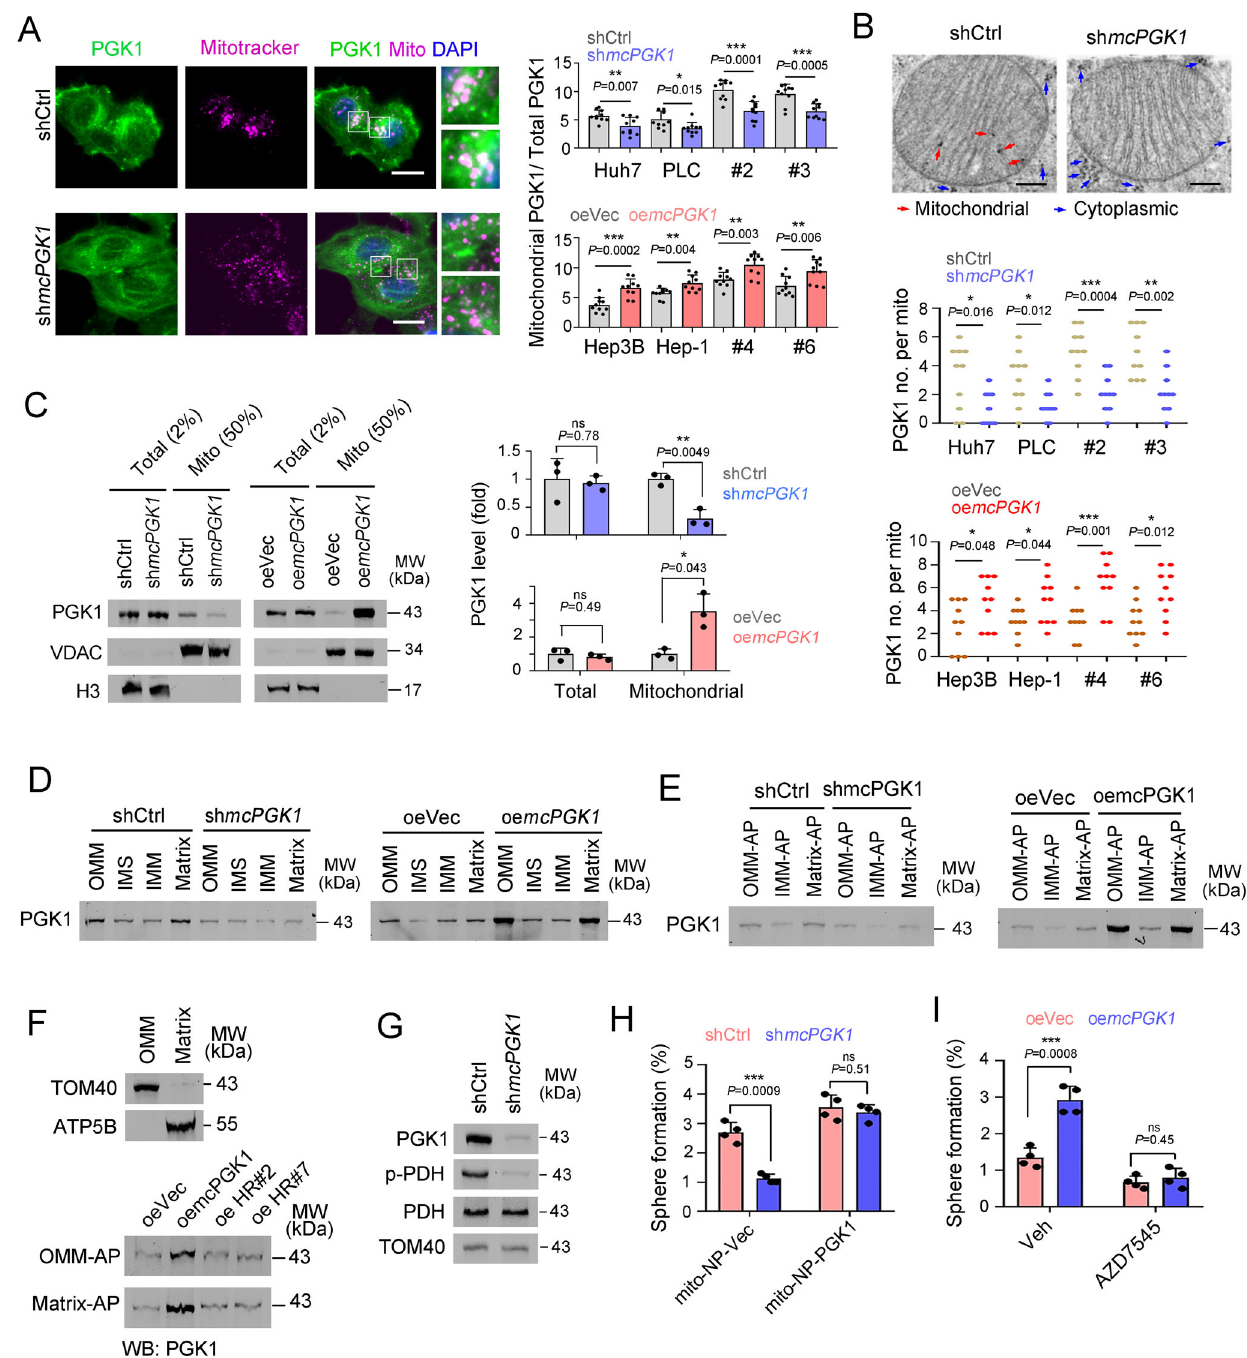
Fig. 8 | McPGK1 promotes the mitochondrial entry of PGK1. A Confocal micro- scopy to detect the intracellular location of PGK1 in mcPGK1 silenced and control cells.Scalebars, 10 μ m. n =10 fi elds pergroup. B Immuno-electronmicroscopyfor the mitochondrial entry of PGK1. n =5 independent experiments with similar results (upper panel) and n =10 mitochondria images for statistical analysis (lower panel). Scale bars, 200nm. C Immunoblots for the mitochondrial entry of PGK1. Voltage-dependent anion channel (VDAC) (mitochondrial) and histone 3 (H3) (nuclear)were used to detectthe purity ofmitochondria. Huh7 cells wereusedfor mcPGK1 knockdown and Hep3B cells were used for mcPGK1 overexpression. n =3 independent experiments. D The indicted fractions of mitochondria were isolated and PGK1 levels were detected with immunoblot. E OMM-APEX, IMM-APEX and matrix-APEX were established in mcPGK1 silenced and overexpressed cells, fol- lowed by streptavidin pulldown and PGK1 immunoblot was performed to detect the enrichment of PGK1 in mitochondria. F Hep3B cells expressing OMM-APEX